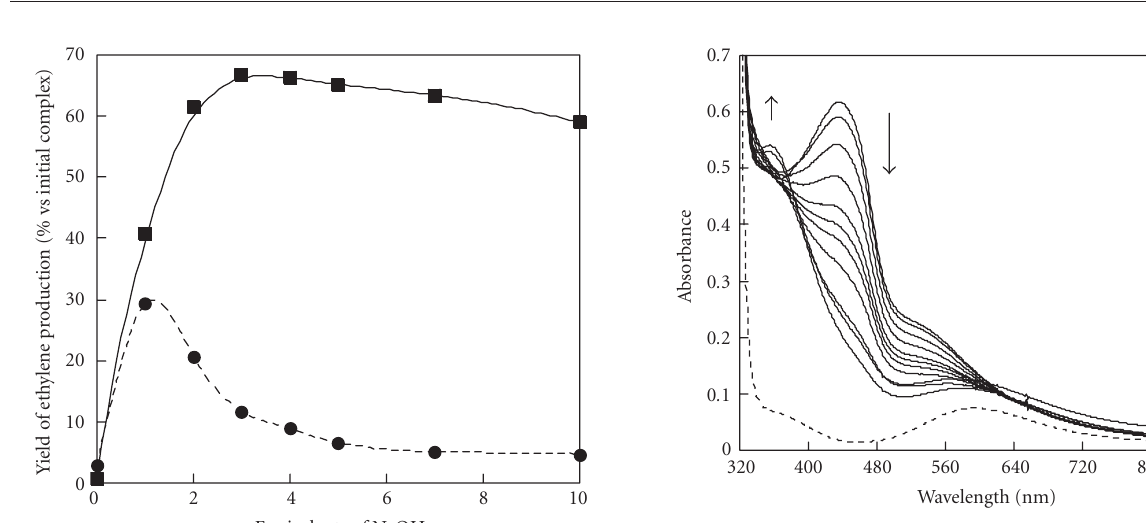
Figure 7: UV-visible spectra of 1mM solution of 1 in MeOH with 1 equivalents of NaOH at − 20 ◦ C: (- - -) initial complex (—) decay of the brown intermediate versus time after addition of 10 equivalents H 2 O 2